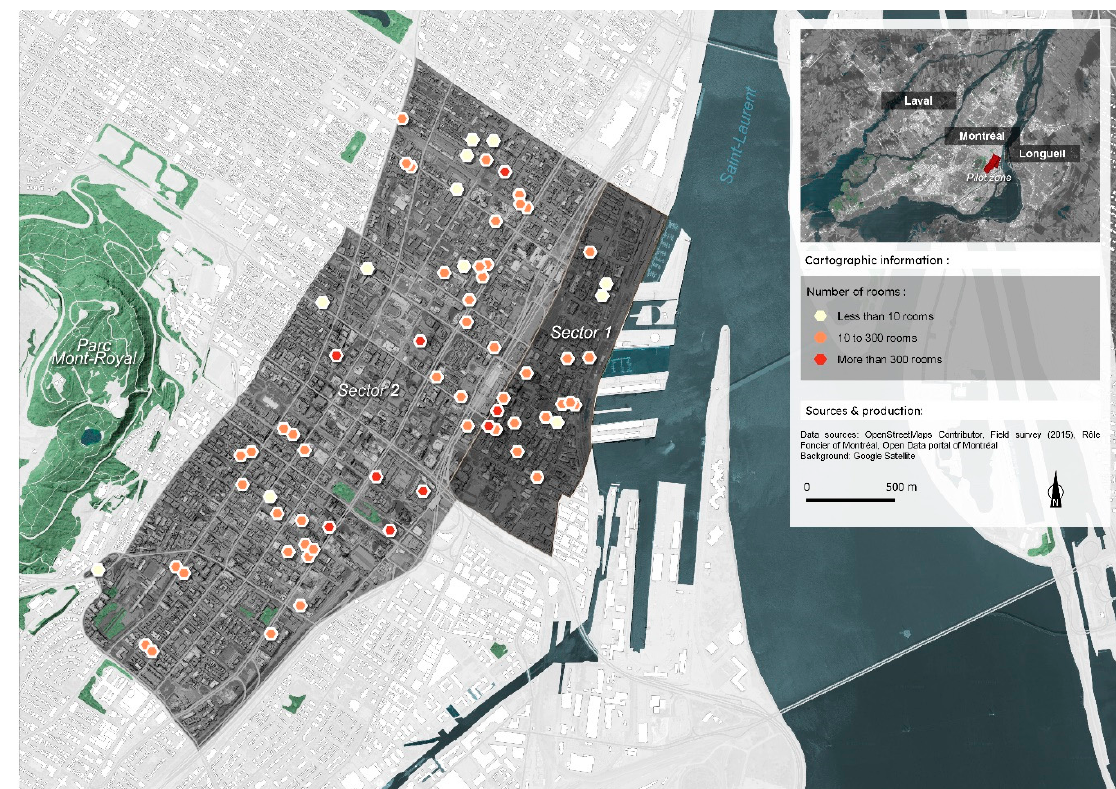
Figure 2. Location of the pilot area divided into two sectors and the investigated touristic accommodations grouped by their number of rooms.